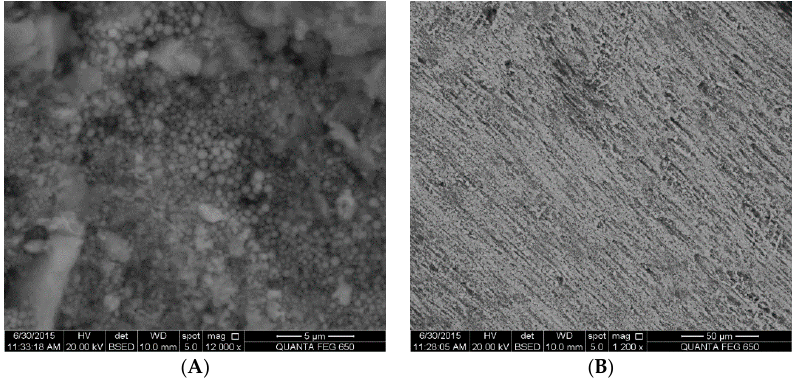
Figure 11. Amorphous glass beads and wheat head formation crystals in 60%-O 2 slag, SEM back-scattering images. ( A ) Amorphous glass beads; ( B ) Wheat head formation crystals.